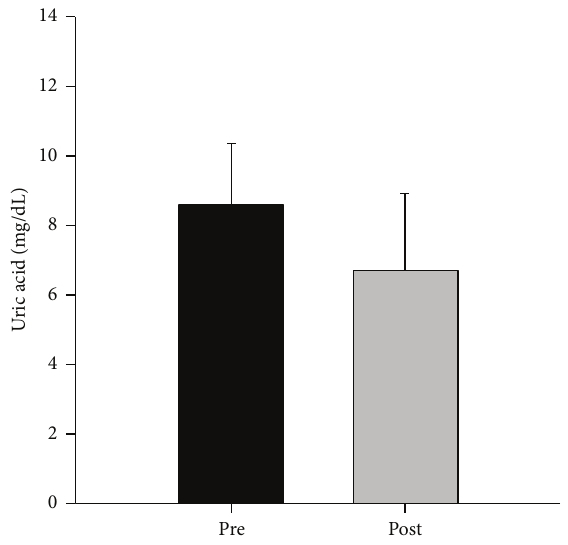
Figure 1: Serum uric acid level pre- and posttreatment ( 𝑛 = 48 ). 40% of them experienced their first gout attack in this joint.